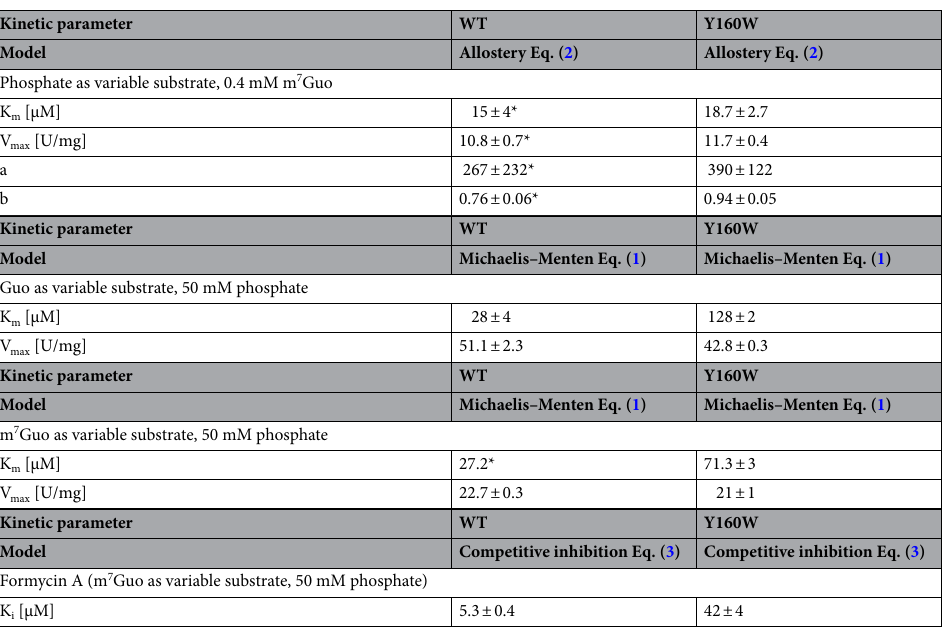
Table 2. The summary of kinetic properties of the WT PNP and the Y160W mutant vs. natural substrates and vs. 7-methylguanosine. Data were obtained at pH 7.0, in 50 mM Hepes buffer, at 25 °C, with 50 mM phosphate using spectrophotometric methods described in “Methods” section. Parameters were obtained from the global fitting and are shown together with their standard deviations. *From 19 , 250 μM m 7 Guo.